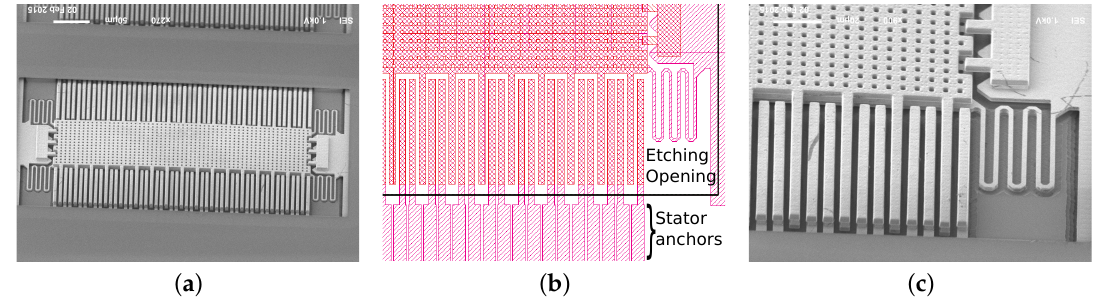
Figure 18. Final lateral device (adapted from [8] with permission, © 2015 IEEE): SEM image ( a ); in the